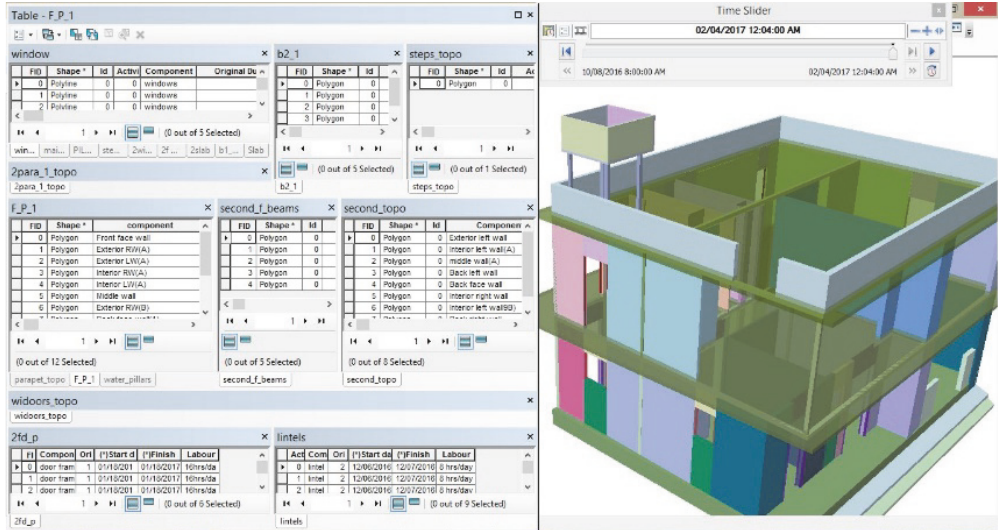
Figure 8: Final complete 4D view along with time line